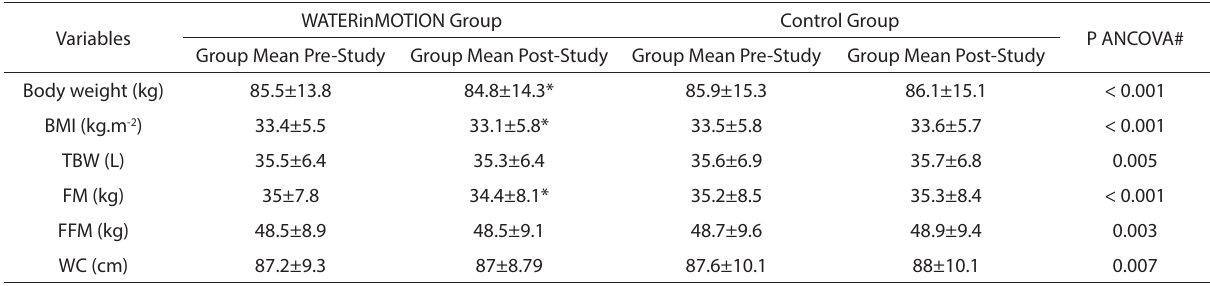
Table 2. Mean of the Studied Groups' Variables Pre- and